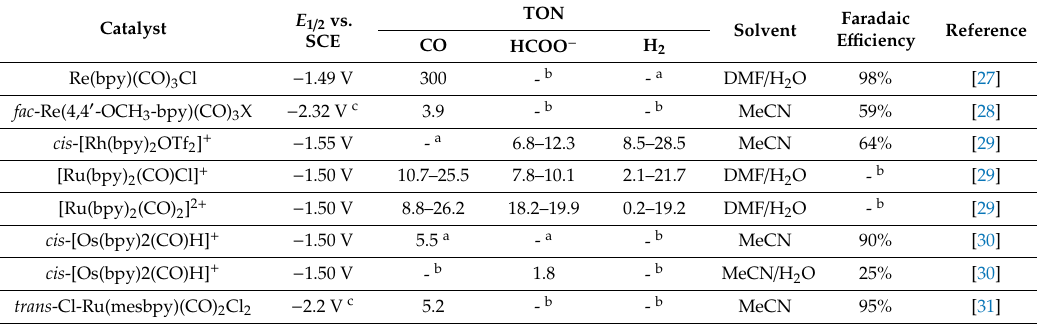
Table 1. 4 d and 5 d metal 2,2 (cid:48) -bipyridine (bpy) catalysts for two-electron CO 2 electroreduction. Table 1. 4 d and 5 d metal 2,2 ′ -bipyridine (bpy) catalysts for two-electron CO 2 electroreduction.